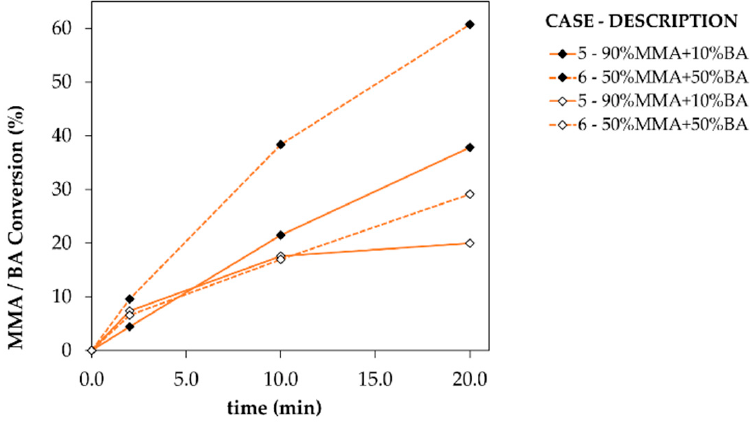
Figure 5. Conversion, as both the percentage MMA consumed ( ◆ ) and BA consumed ( ◇ ) versus the reaction time for the coformulation cases in Table 1 in which BA is present, namely Cases 5 and 6. Both cases are starting at room temperature.